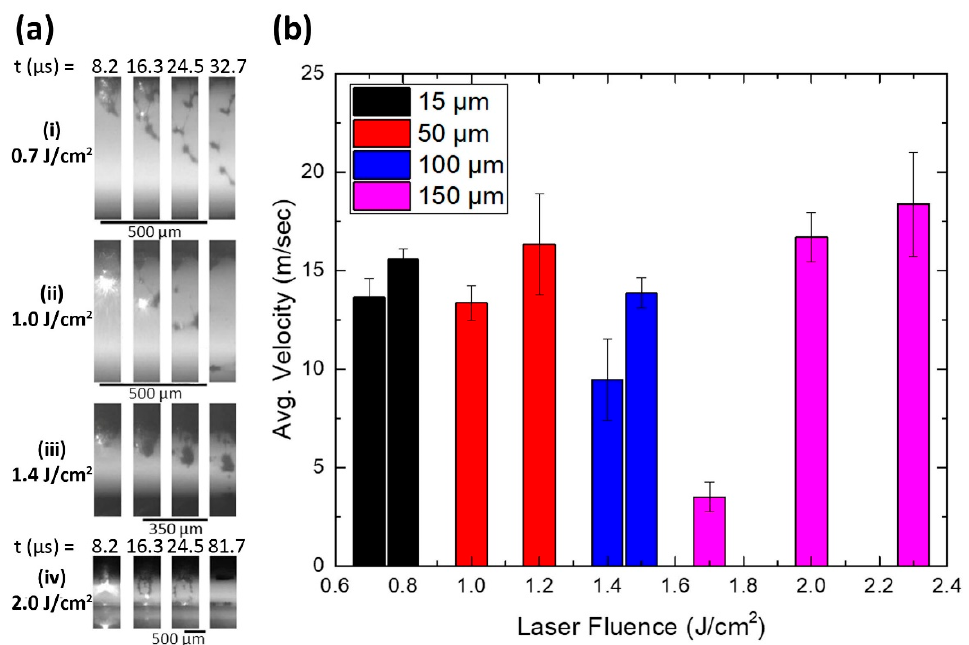
Figure 2. ( a ) Sequence of frames extracted from videos acquired at 122,400 fps for solder paste propagation from a donor layer thickness set by the film applicator at ( i ) 15 μ m and using laser fluence of 0.7 J/cm 2 ; ( ii ) 50 μ m and using laser fluence of 1.0 J/cm 2 ; ( iii ) 100 μ m and using laser fluence of 1.4 J/cm 2 ; ( iv ) 150 μ m and using laser fluence of 2.0 J/cm 2 . The donor-receiver gap was set at ( i , ii ) 500 μ m, at ( iii ) 350 μ m and at ( iv ) 600 μ m. ( b ) Ejection velocities as a function of laser fluence for the four different solder paste donor thicknesses: 15 μ m (black), 50 μ m (red), 100 μ m (blue) and 150 μ m (magenta). The standard deviation resulting from a set of 10 repeats is also marked.